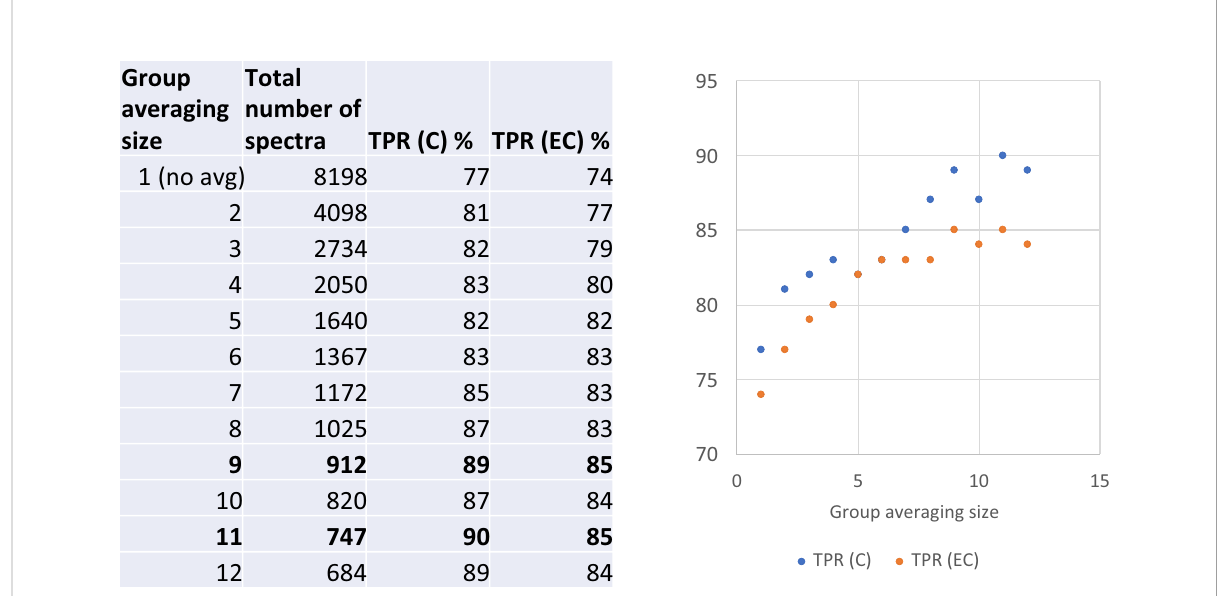
FIGURE 5 The accuracy of differentiation between serologically negative (EC) and LD-con fi rmed (C) groups of human blood samples when averaged in different sized groups. TPR denotes a true positive